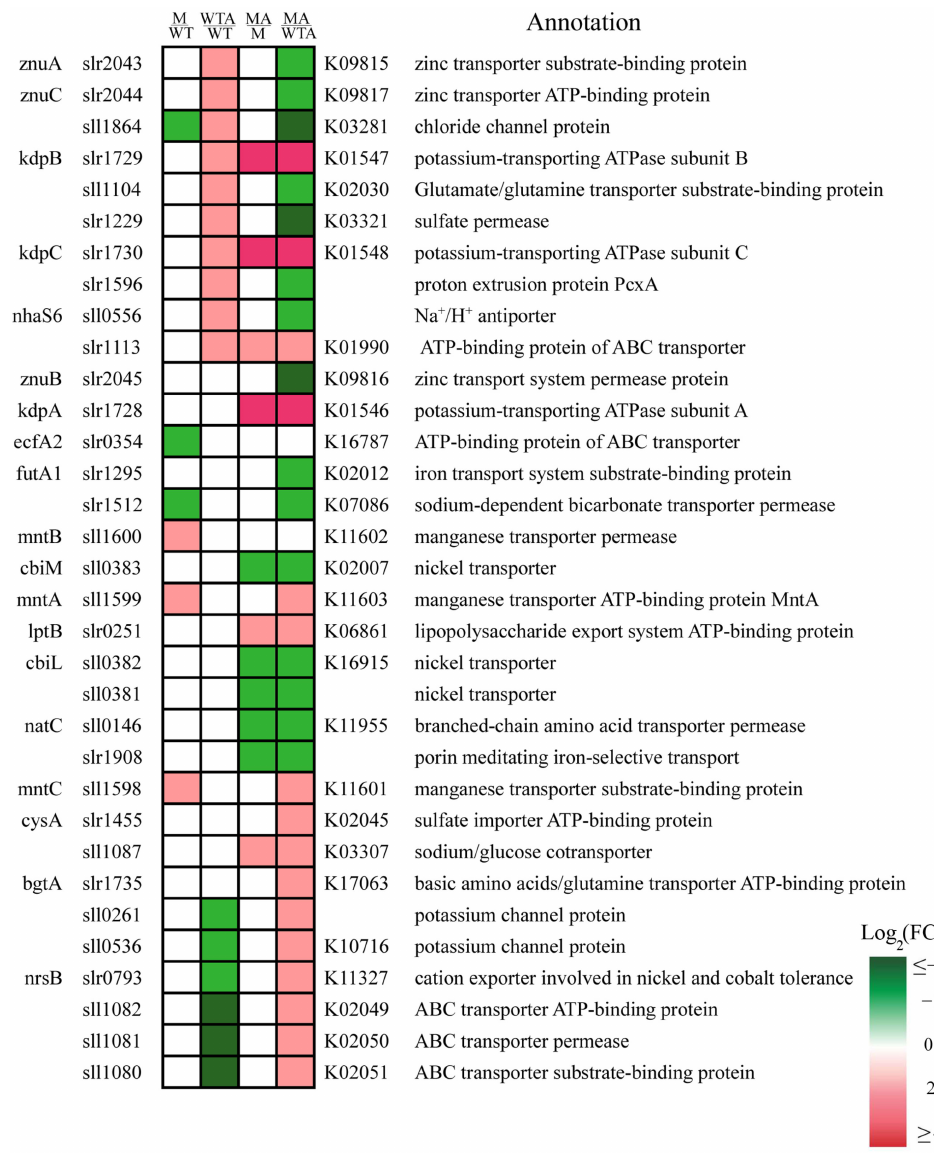
Figure 5. Ordered expression ranks for differentially expressed transporter-related genes. Ranks are ordered according to the log 2 (FC) of WTA/WT. The heatmap illustrates the log 2 (FC) of four comparisons in colors as indicated. WT and WTA are wild type without and with NH 4 + stress. M and MA are ∆ slr1821 knockout mutants without and with NH 4+